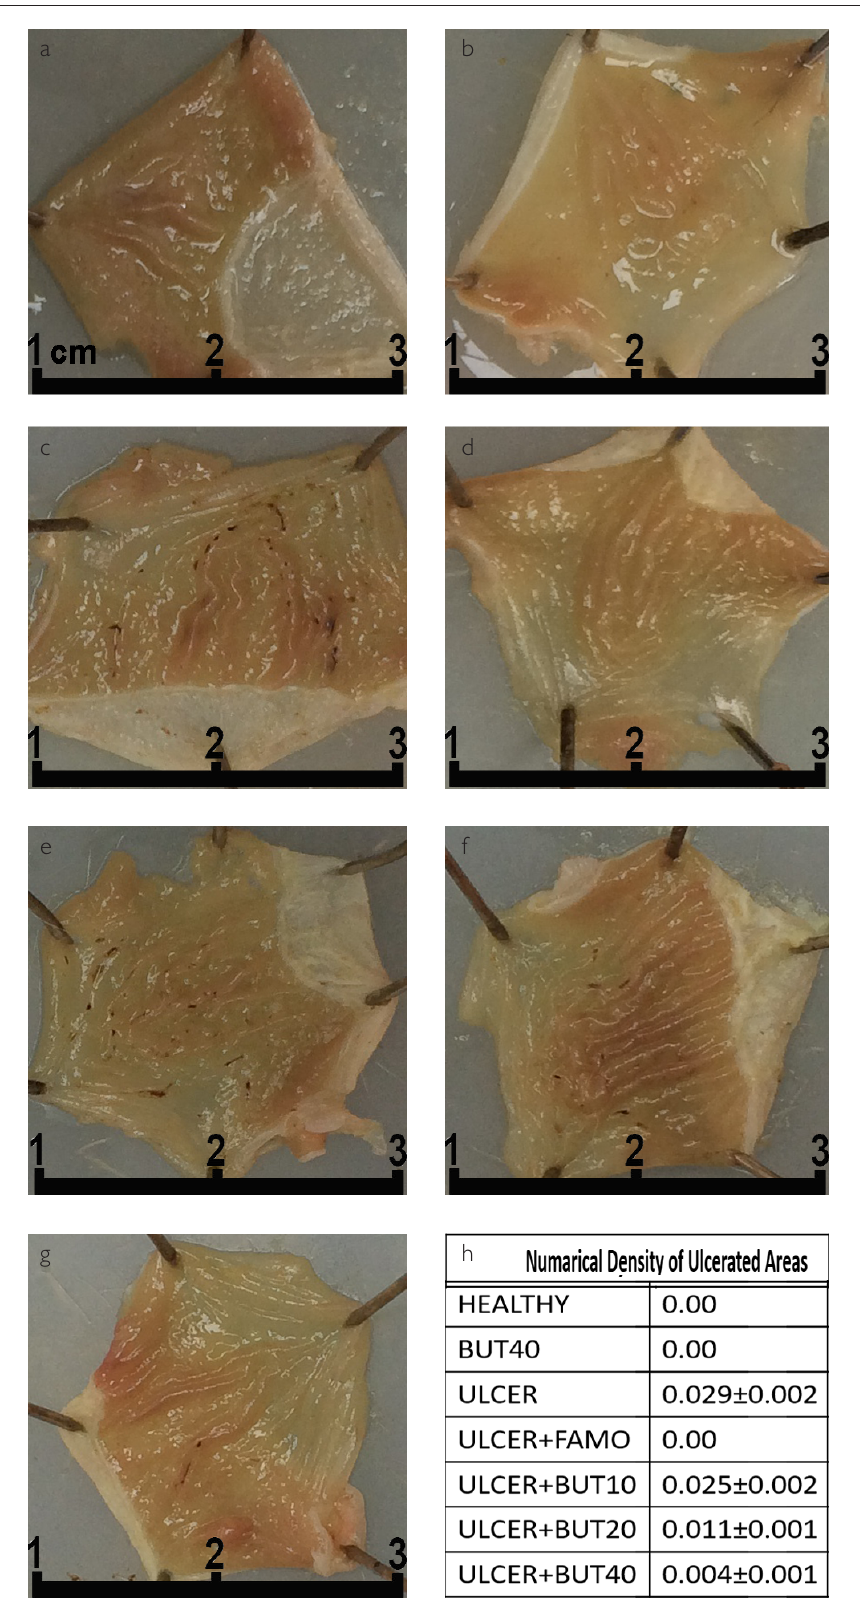
Figure 1. a-h. ample images; (a) Healthy, (b) BUT40, (c) INDO (ulcer), (d) INDO+FAMO, (e) INDO+BUT10, (f) INDO+BUT20, (g) INDO+BUT40, (h) Numerical densities of ulcerated hematomas from each group. In our study, numerical density of the ulcerated area has been calculated by dividing the total number of ulcer areas by total volume of stomach